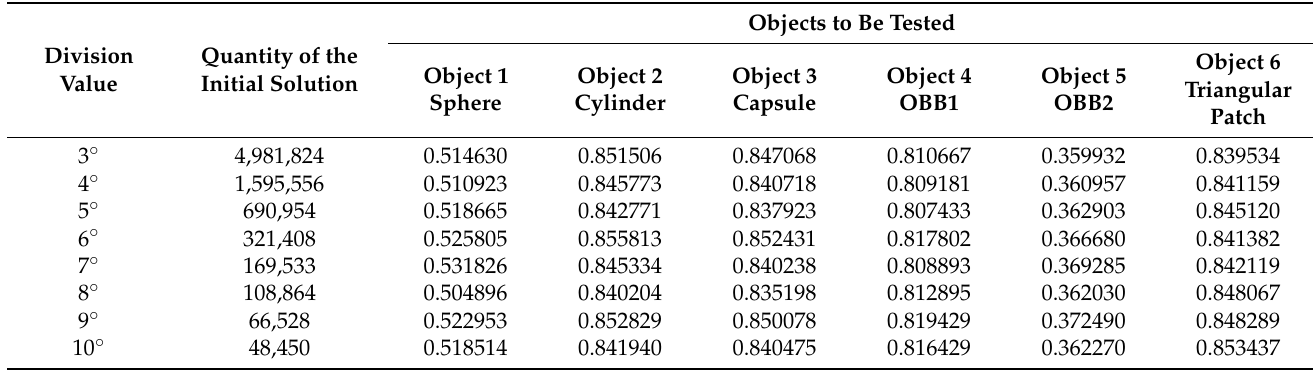
Table A3. DOR (dimensionless) Comparison Under Different Division Values.